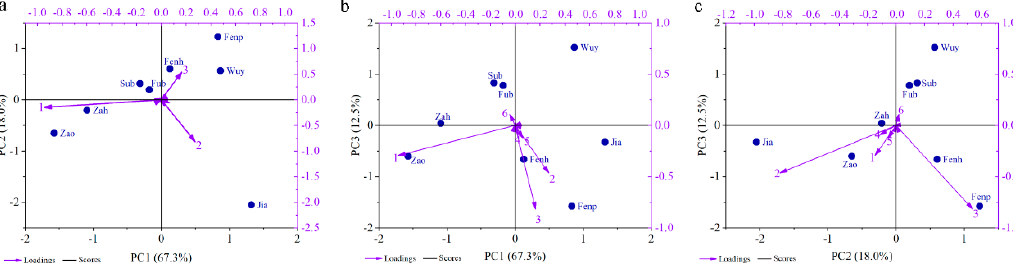
Figure 3. PCA of the emission amount of floral scent compounds separated the eight P. mume cultivars. ( a ) 2D type of component plot of PC1 and PC2. ( b ) 2D type of component plot of PC1 and PC3. ( c ) 2D type of component plot of PC2 and PC3. Violet axis represents the loading value of the compounds. Black axis represents the score of the cultivars. Numbers represent the major scent components: 1: benzyl acetate; 2: benzyl alcohol, 3: cinnamyl acetate, 4: eugenol, 5: cinnamyl alcohol, 6: benzyl benzoate.